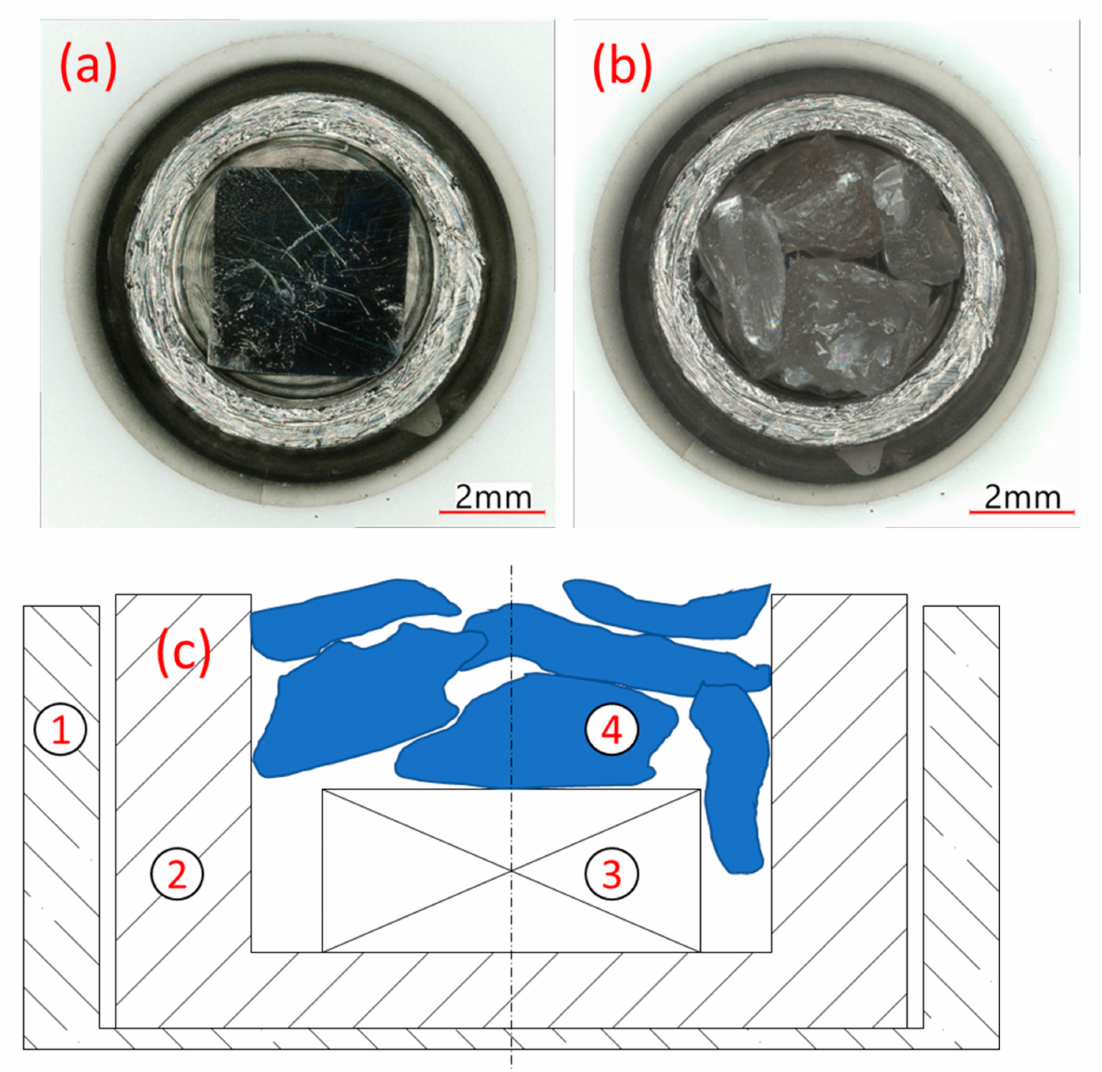
Figure 2. ( a ) Experimental set-up without slag chunks; ( b ) and with slag chunks. ( c ) Schematic drawing of dual-crucible set-up with (1) alumina crucible; (2) ULC crucible; (3) steel specimen; and (4) slag specimen